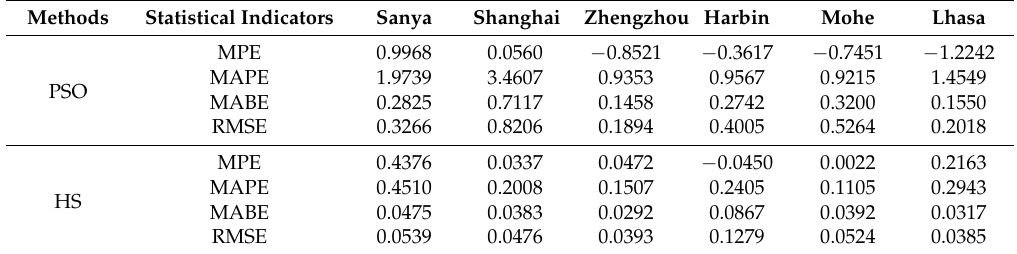
Table 4. Statistical indicators (mean percentage error (MPE), mean absolute percentage error (MAPE), mean absolute bias error (MABE), root mean square error (RMSE)) of PSO and HS at six different climatic